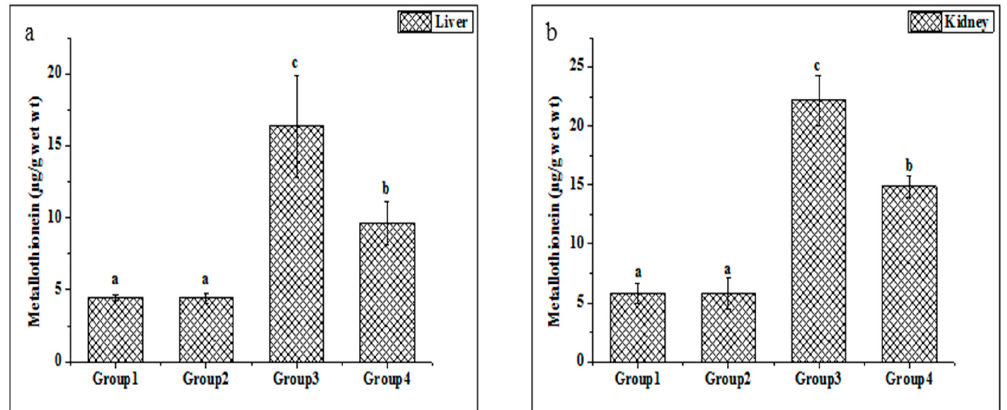
Figure 3. Effect of juice extract of O. stricta on Cd-induced changes in the levels of metallothionein in the liver ( a ) and kidney ( b ) of control and experimental rats. Group 1: Normal rats. Group 2: Juice extract (250 mg/kg)-treated rats. Group 3: CdCl 2 (1 mg/kg)-treated rats. Group 4: CdCl 2 + juice extract (250 mg/kg)-treated rats. Values are mean ± SD for 6 rats in each group. Bars not sharing a common superscript letter (a, b, c) differ significantly at p < 0.05 (Duncan).